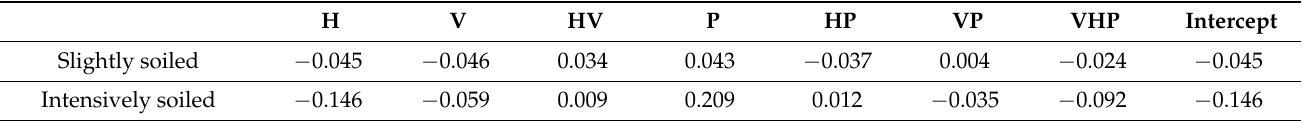
Figure 10. Response volume for slightly soiled mirror ( left ) and intensively soiled one ( right ). P is the ultrasonic power; H is the gap and V the sweeping speed. Table 6. Effect of factors for codified